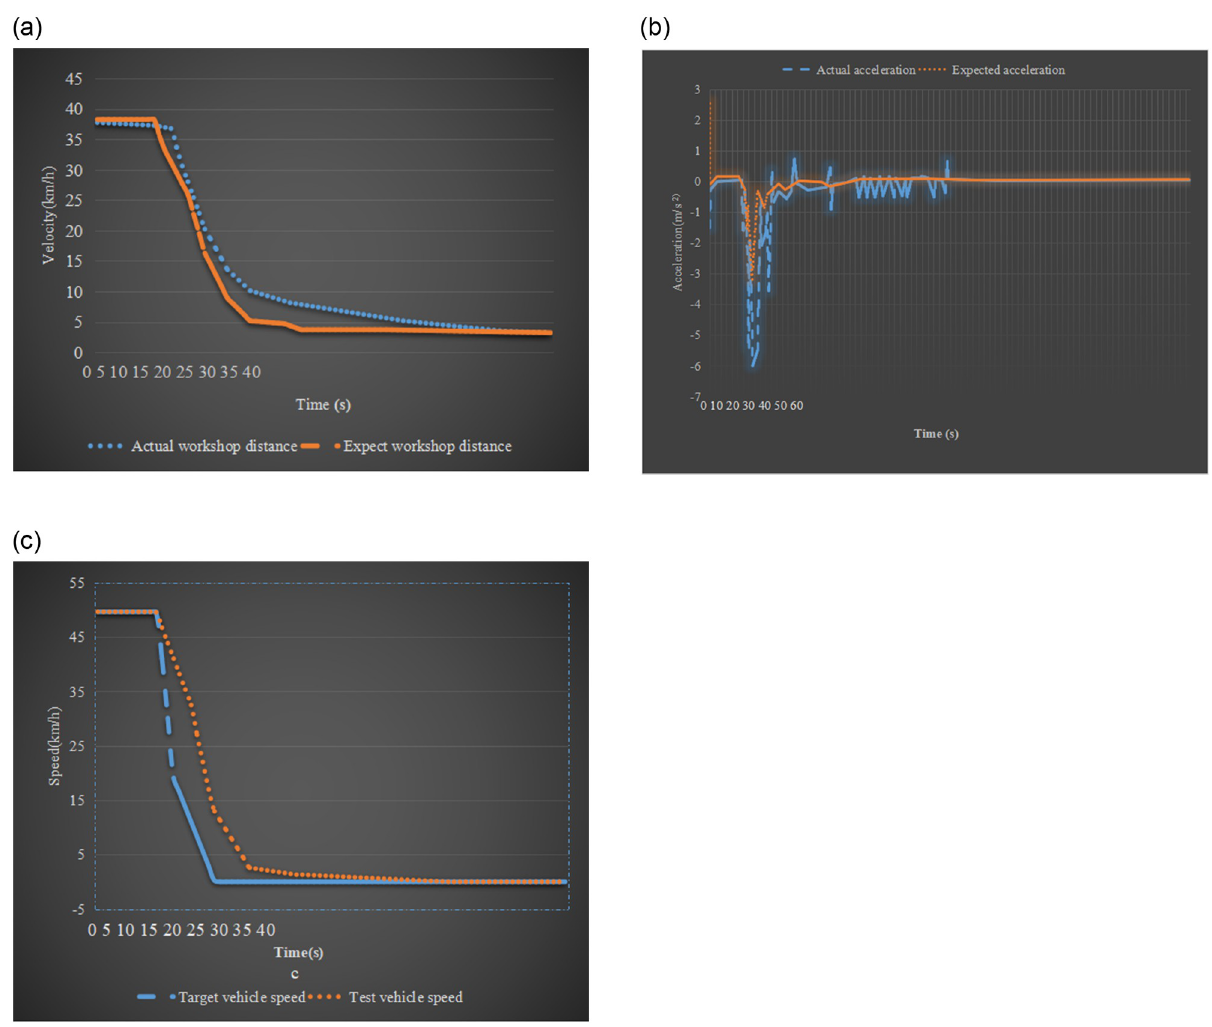
Fig 15. Anti-collision simulation results of the target vehicle’s emergency deceleration (a) Comparison between actual distance and expected distance (b) Comparison between actual acceleration and expected acceleration (c) Comparison of two vehicle speeds.